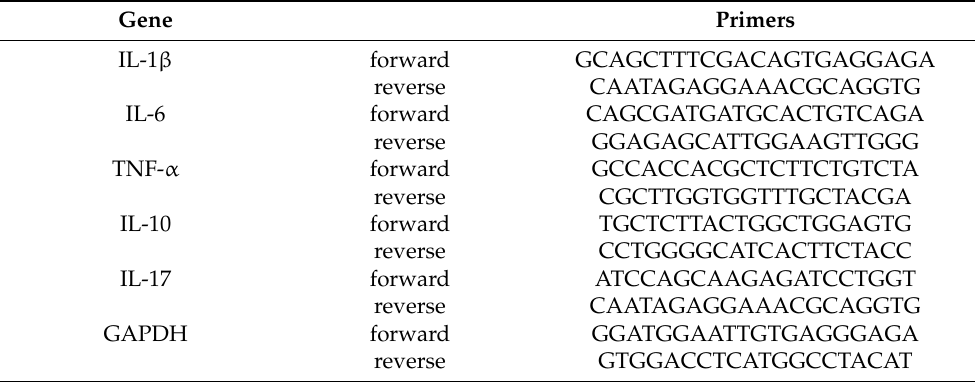
Table 1. PCR primers used in the